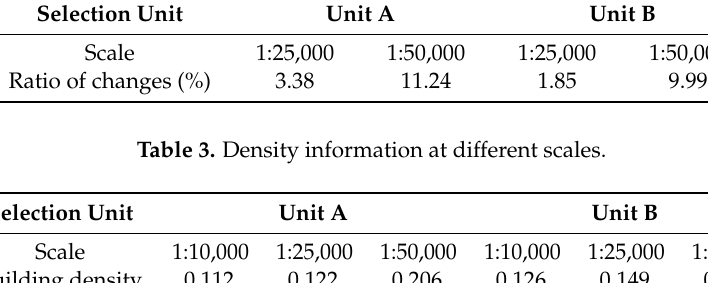
Table 3. Density information at different scales.